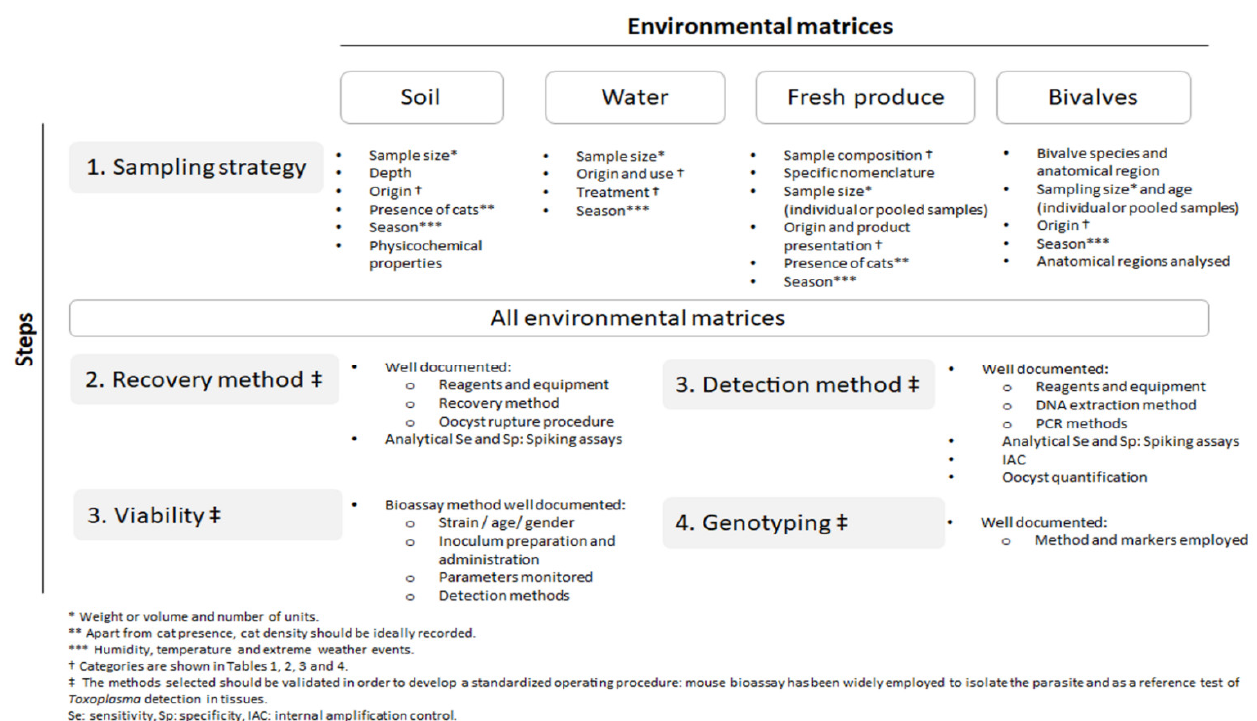
Figure 3. Workflow and key considerations for standard sampling strategies and detection methods for Toxoplasma gondii in environmental matrices.